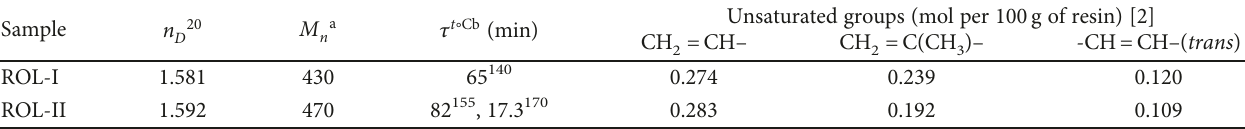
Table 1: Characteristics of uncured rolivsan thermosetting resins.